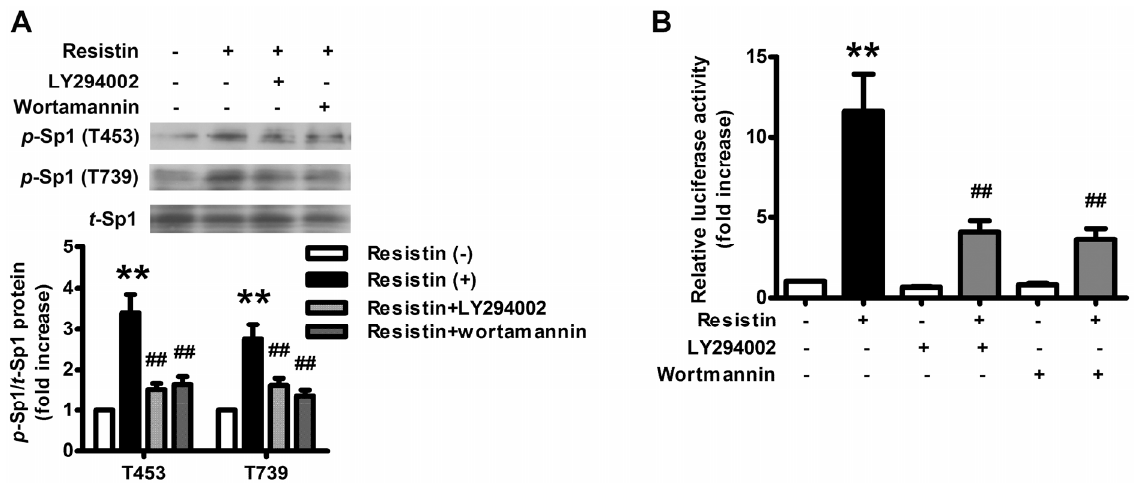
Figure 4. Activated PI3K/Akt upon resistin interacted with Sp1 and activated it through phosphorylation. ( A ) Blockage of resistin-induced Sp1 activation by LY294002 and wortmannin in HO-8910 cells. Cells were pretreated with (+) or without ( − ) LY294002 (20 μ M) and wortmannin (2 μ M) for 1 h, then incubated in the presence (+) or in the absence ( − ) of resistin 100 ng/mL for 2 h. The top panel is a representative blot obtained from three independent experiments. The lower panel represents the summary results of Sp1 phosphorylation at either Thr-453 or Thr-739. Relative phosphorylated Sp1 protein levels were normalized to that of untreated cells; ( B ) Attenuation of resistin-induced Sp1 binding activity by LY294002 and wortmannin in HO-8910 cells. Cells were transfected with pSp1-luciferase reporter together with control plasmid. After being pretreated with (+) or without ( − ) LY294002 (20 μ M) and wortmannin (2 μ M) for 1 h, cells were incubated in the presence (+) or in the absence ( − ) of resistin 100 ng/mL for 24 h. Data are mean ± SEM from four independent triplicated experiments. The basal binding activity of each test plasmid is indicated as luciferase activity normalized by each internal control activity (PRL-TK). Relative luciferase activity was normalized with respect to the activity in untreated